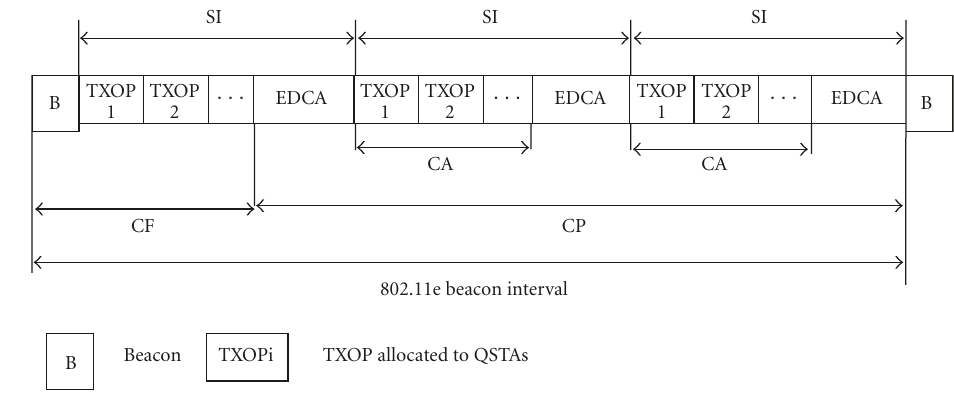
Figure 4: Structure of the 802.11e beacon interval.